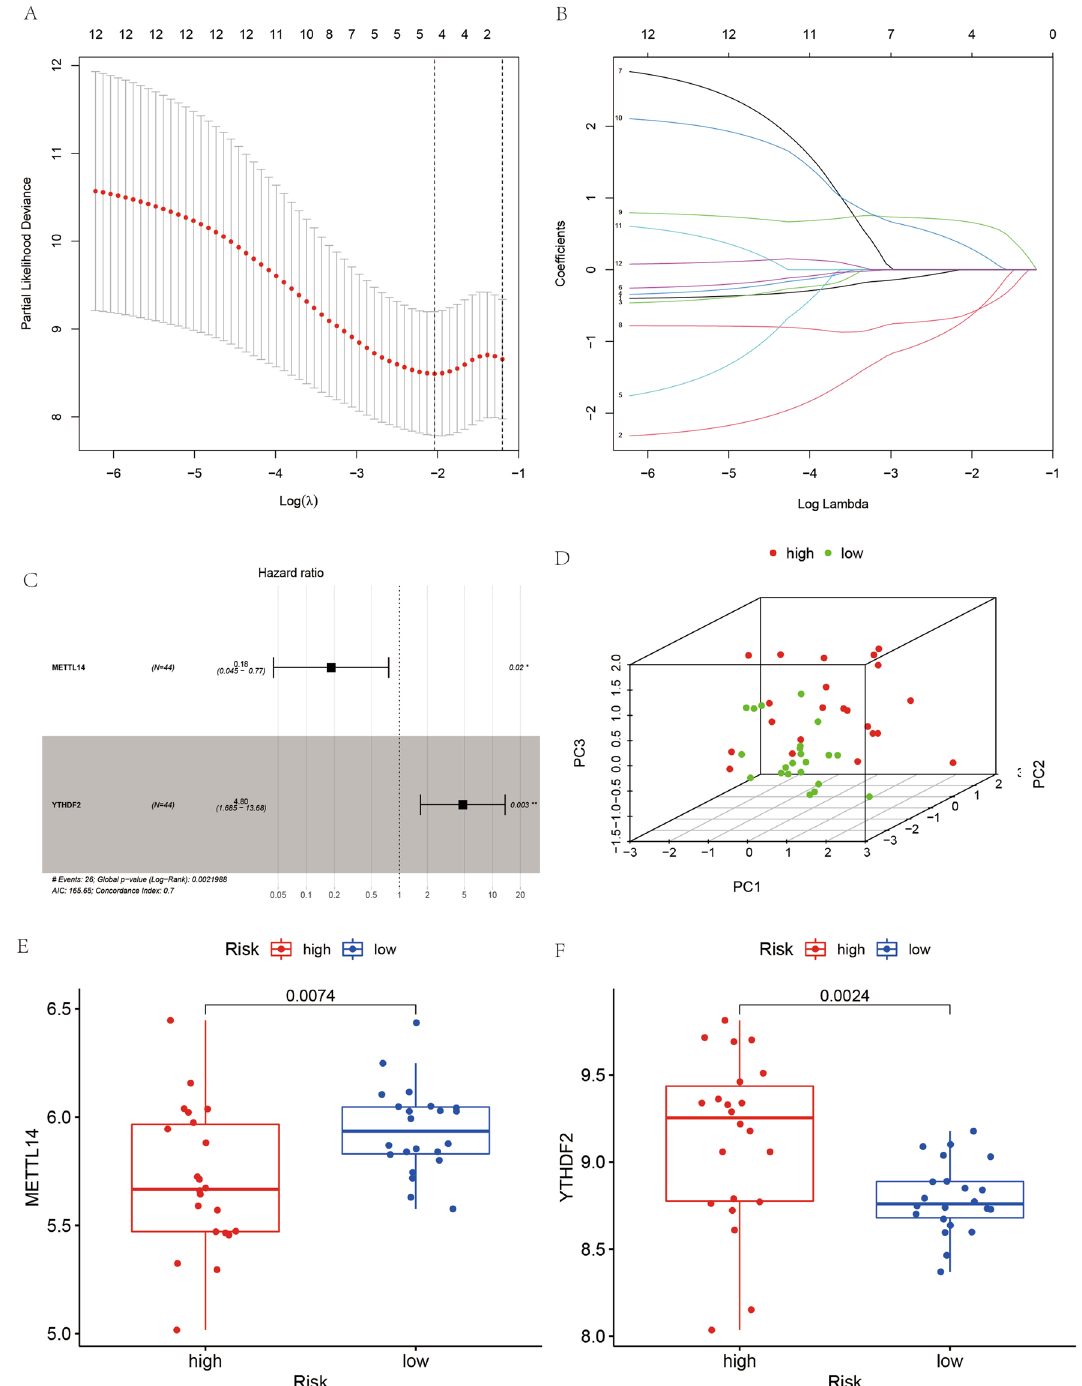
Figure 5. Diagram of the construction process of the prognostic model. ( A ) and ( B ) represent the results of the LASSO regression analysis. ( C ) represents a plot of the results of the multivariate COX regression analysis. ( D ) shows the 3D-principal component analysis plot, with red points indicating high-risk cases and green points indicating low-risk cases. ( E ) and ( F ) indicate the expression of METTL14 and YTHDF2 in the high-risk group and in the low-risk group,